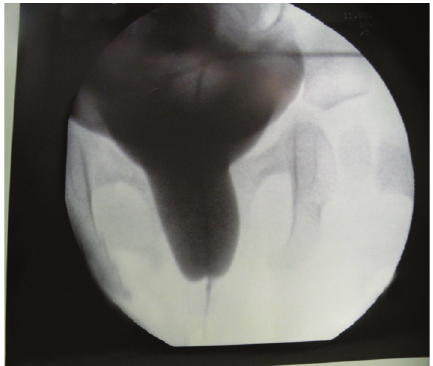
Figure 4: Intraoperative cystourethrogram showing sudden nar- rowing of the